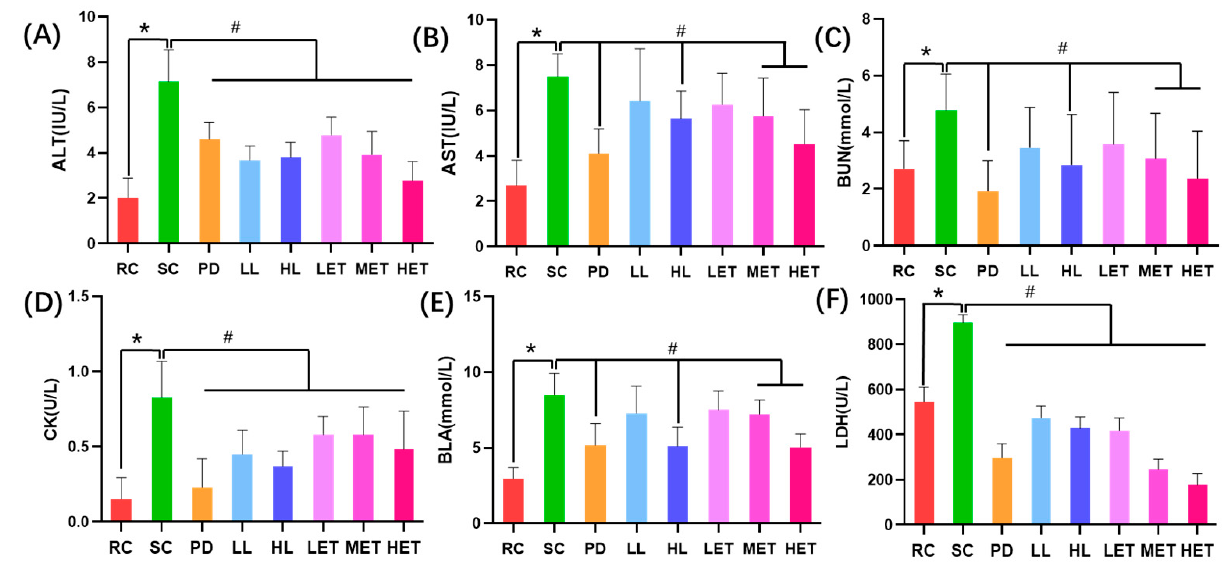
Figure 5. The effects of LBP and LBPT on serum biochemical parameters. ( A ) ALT, ( B ) AST, ( C ) BUN, ( D ) CK, ( E ) BLA, ( F ) LDH. Data are expressed as mean ± SD, N = 8, *: vs. RC p < 0.05, #: vs. SC, p < 0.05.